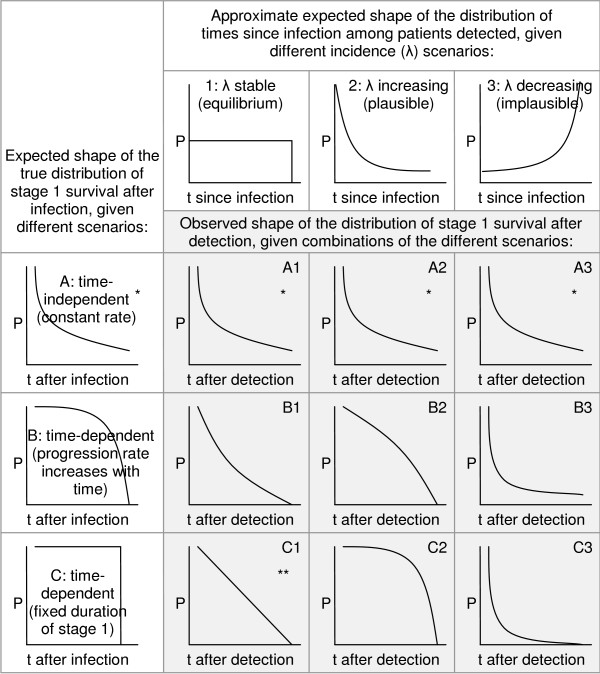
Expected shapes of the observed distribution of survival times after detection. Shaded cells A1-C3 show the expected distribution of survival times after detection, given different scenarios for the true distribution of stage 1 survival (A, B and C) and incidence in the pre-detection period (1, 2 and 3). P = proportion of cases remaining in stage 1; t = time; * = exponential function P(t)=e(−r1t), with mean stage 1 duration = 1/r1; ** = linear function P(t) = -r1t with fixed stage 1 duration = 1/r1.